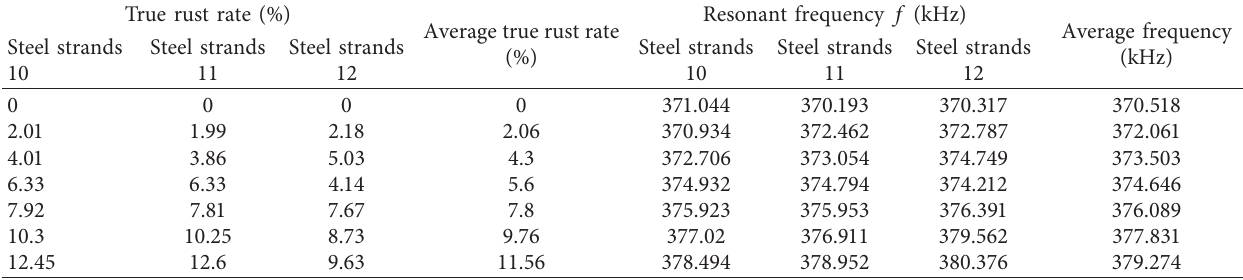
Table 7: Test data of the fifth group of steel strands.